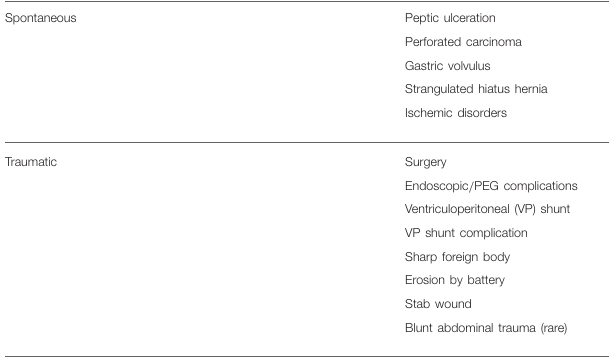
TABLE 1 | Causes of gastric